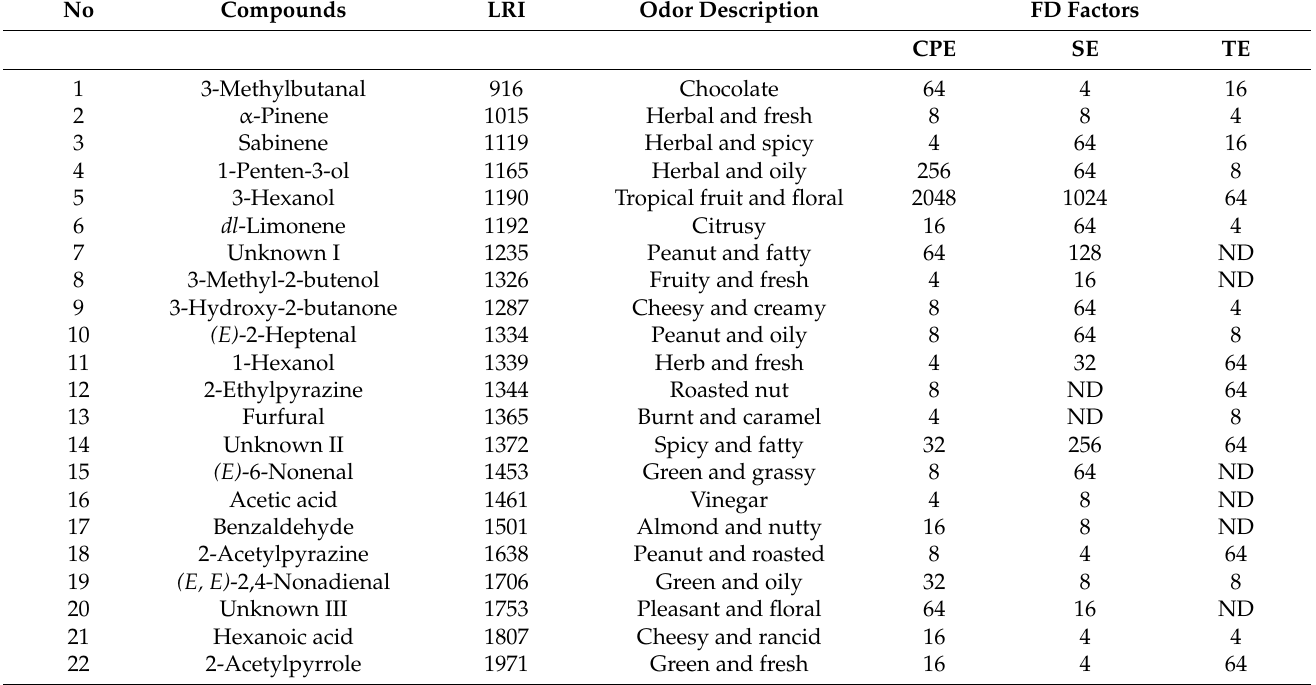
Table 4. Aroma-active compounds of shea butter (FD ≥